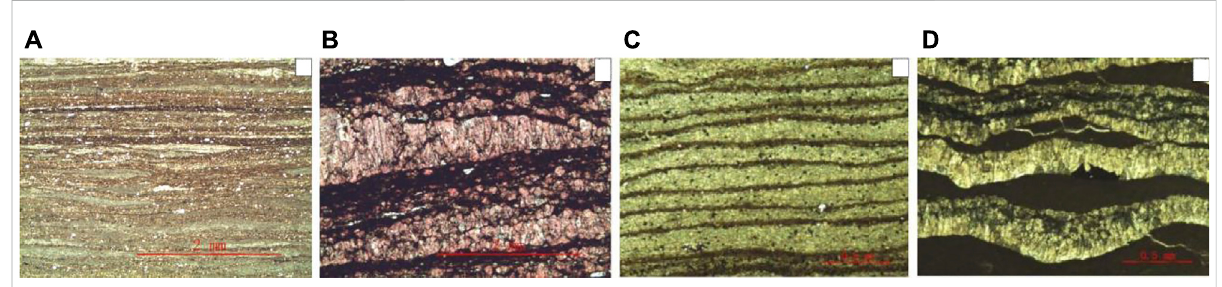
FIGURE 6 Typeandcharacteristicsofshaletexture. (A) Sedimentaryformationofgrainlayer. (B) Thegrainlayer (C) ,whichisinheritedfromdepositionand mainly formed by diagenesis. Granular calcite and mud layer interlayer. (D) Fragmentedsedimentary layers are visible inthe columnar calcite stripes.